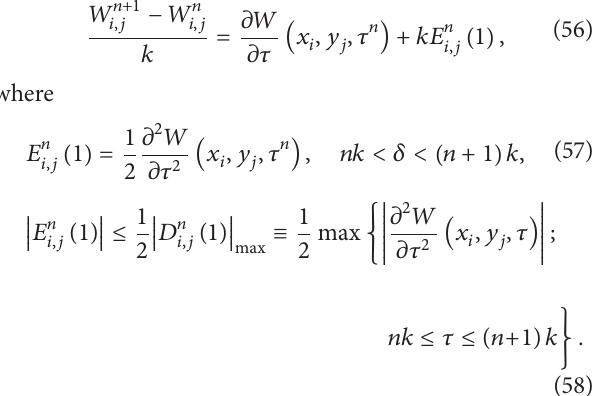
Figure 2: Five-point versus nine-point stencils.